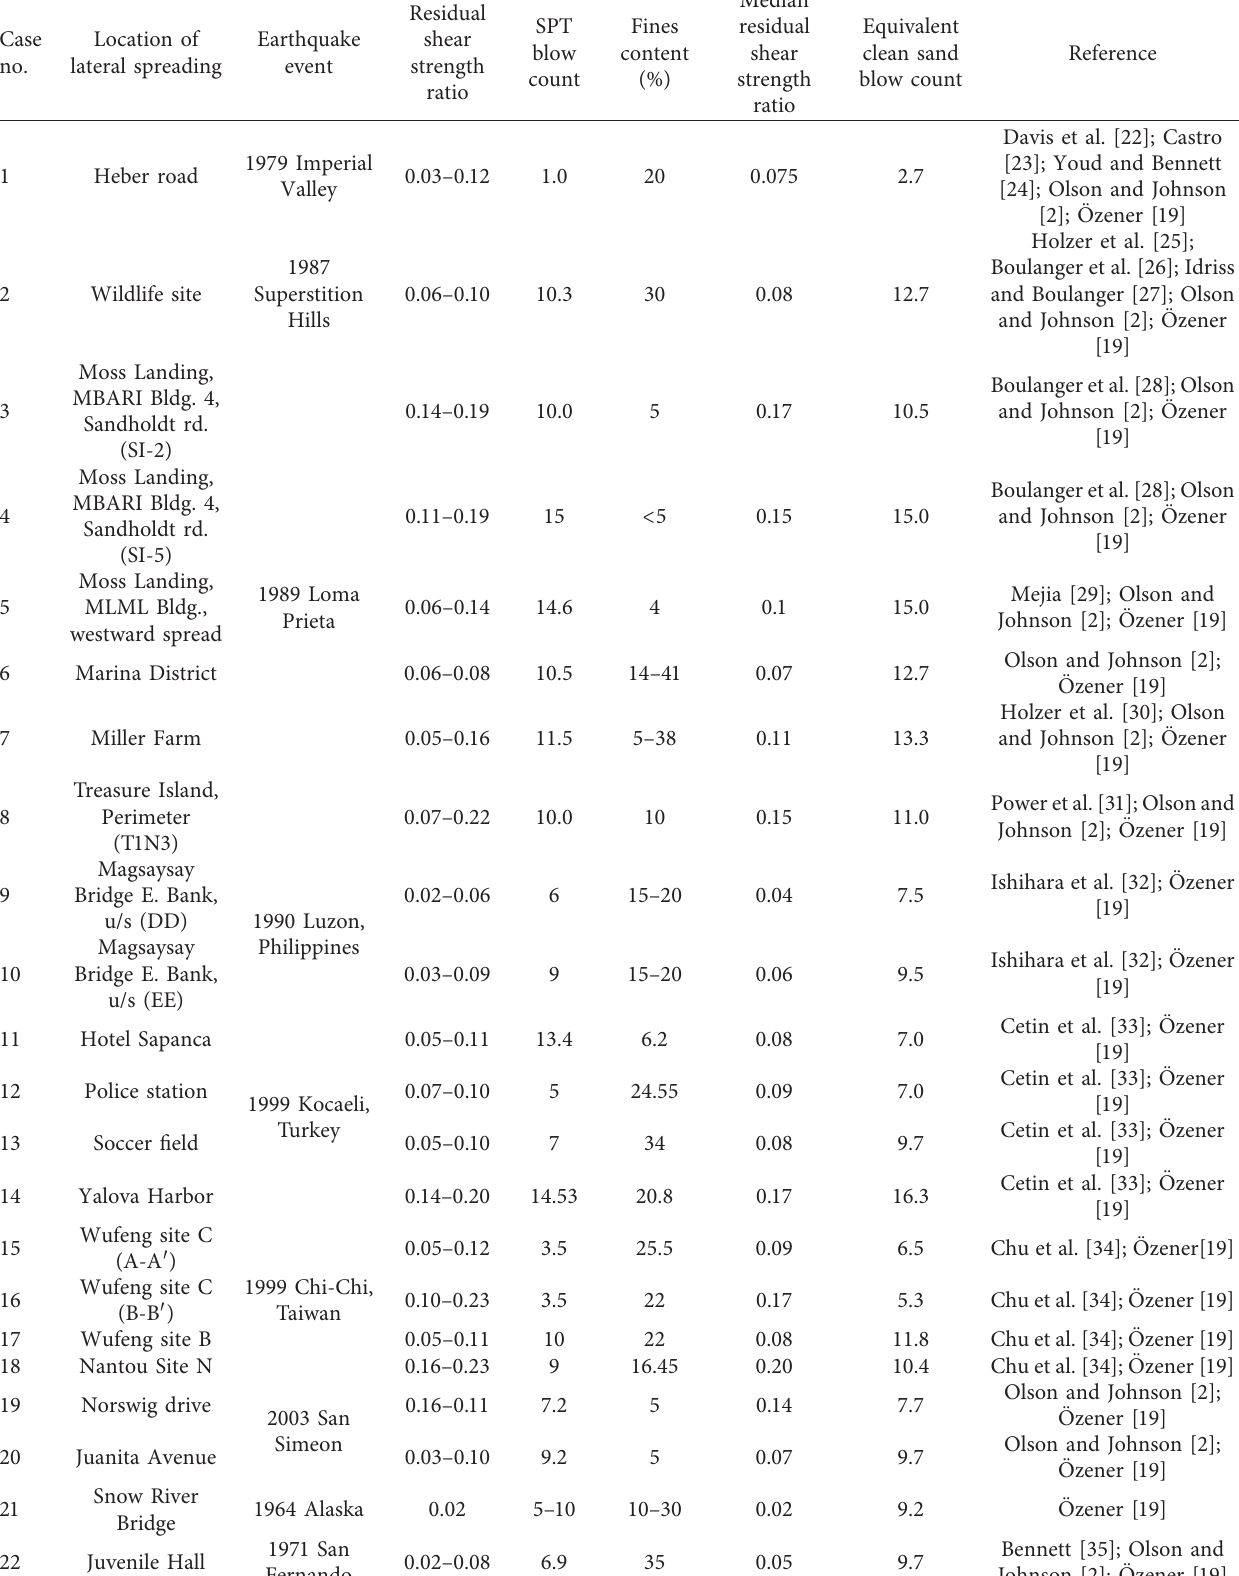
Table 2: Case histories of lateral spreading used for training Artificial Neural Network